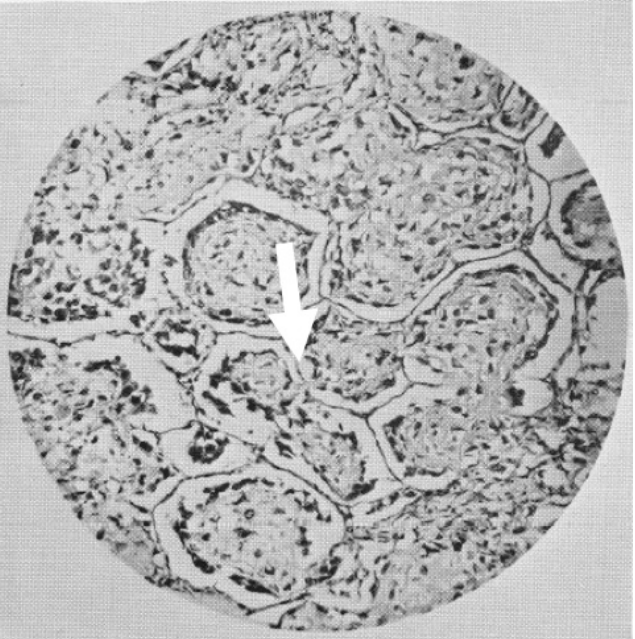
Figure 3. A non-angiogenic lung metastases from an osteosarcoma presented by Rupert A. Wills in his 1934 book The Spread of the Tumours in the Human Body . In the words of the author: “ Sections of a pulmonary metastasis showing alveoli occupied by plugs of growth resembling osteoid tissue. Note the strands of growth connecting the alveolar plugs trough the septal pores .”